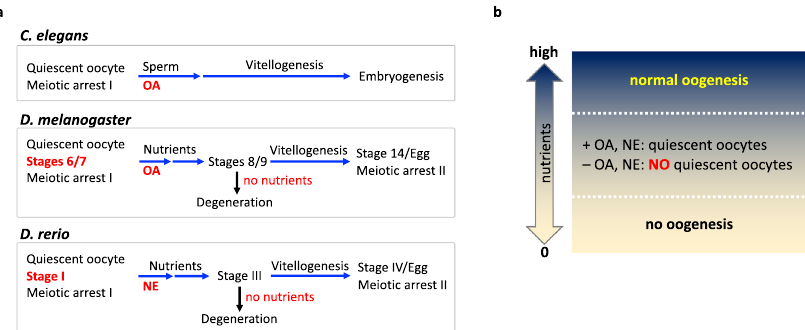
Fig. 8 The model. a The summary of oogenesis in different models shows the step and the stage where the noradrenergic input is required to maintain oocyte quiescence. Oocyte quiescence is maintained by OA. Quiescent oocytes are awakened by sperm in C . elegans and by nutrients in D . melanogaster . In zebra fi sh, NE would be overridden by nutrients, which serve as a signal of PFA. Under starvation conditions, early stage vitellogenic oocytes are subjected to degeneration in D . melanogaster and zebra fi sh. b For fl ies and zebra fi sh, oogenesis is tightly regulated by availability of food. When nutrients are completely deprived (0), oogenesis does not initiate due to lack of building blocks and energy. When nutrients are abundant (high), oogenesis progresses in full speed overriding any inhibitory signals such as NE/OA. When the nutrient level is insuf fi cient for continuous oogenesis, NE/OA serves as a counterbalance signal to nutrients; oogenesis stops, and oocytes become quiescent waiting for the condition to be